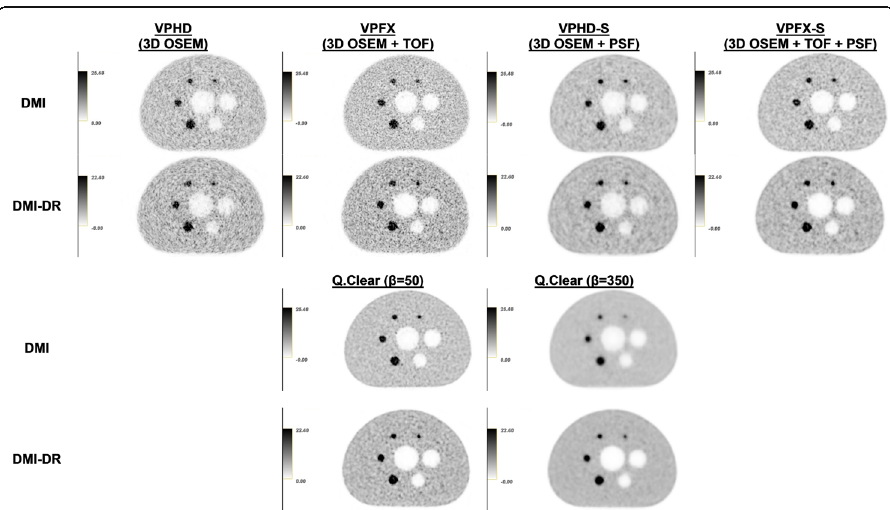
Fig. 3 Central slices of the NEMA IEC image quality body phantom acquired during the image quality tests for the Discovery MI and Discovery MI-DR PET/CT systems. Images were reconstructed with the VPHD (3D OSEM), VPFX (3D OSEM + TOF), VPHD-S (3D OSEM + PSF), VPFX-S (3D OSEM + TOF + PSF) reconstruction algorithms and with Q.Clear, with β = 50 and β = 350. The gray-scale next to each phantom image represents the activity concentration in